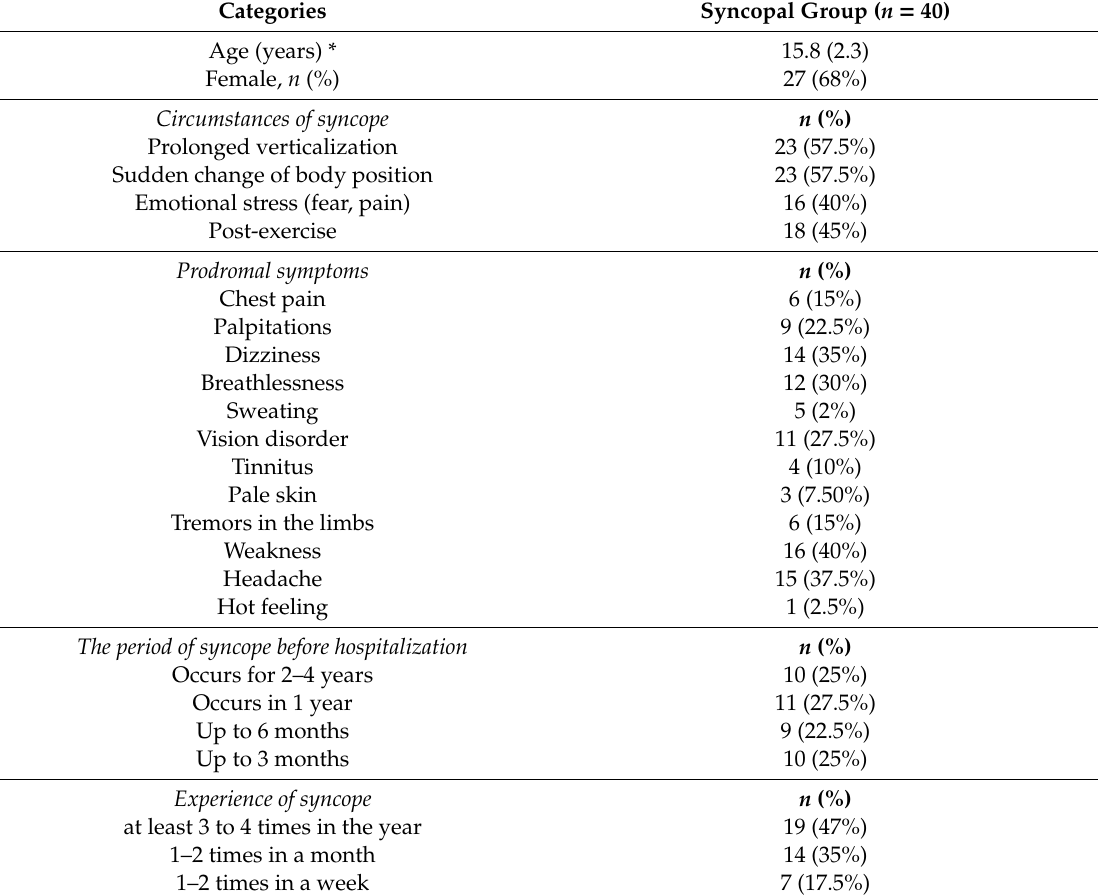
Table 1. Clinical characteristics of children with vasovagal syncope (VVS) (Syncopal